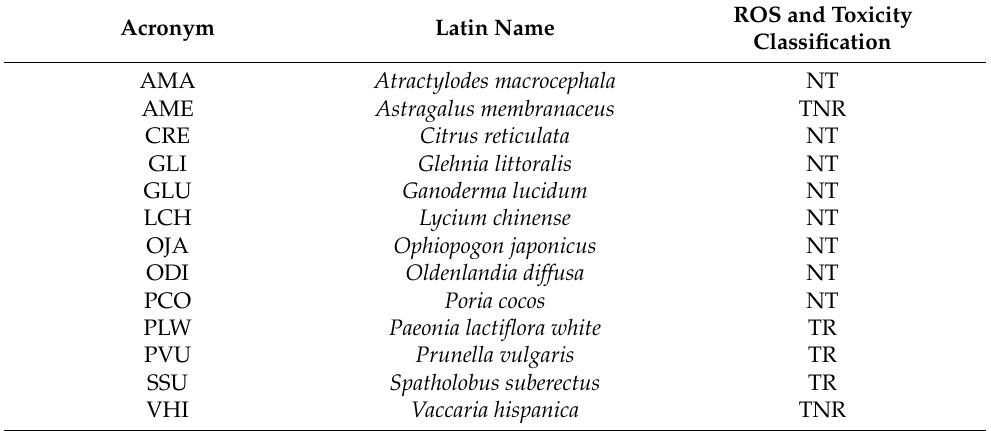
Table 1. Botanical names and